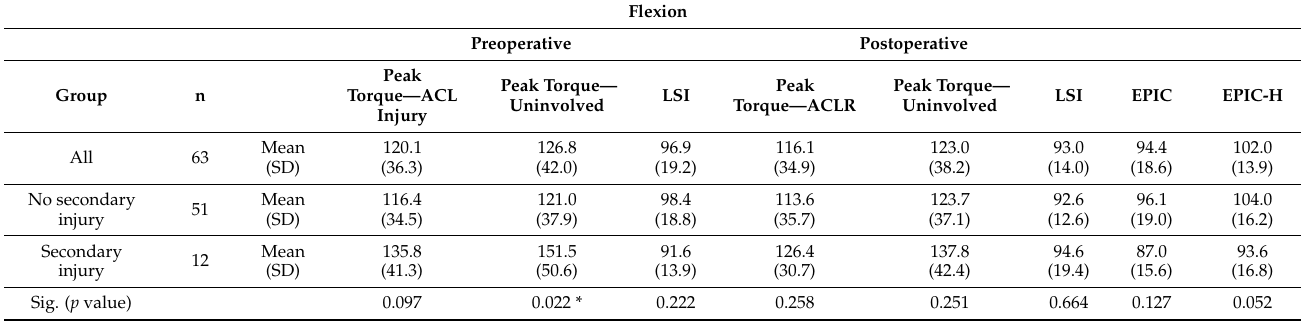
Table 3. Mean peak torque (Nm) values for knee flexion, LSI, and comparison between groups with secondary ACL injury and without secondary